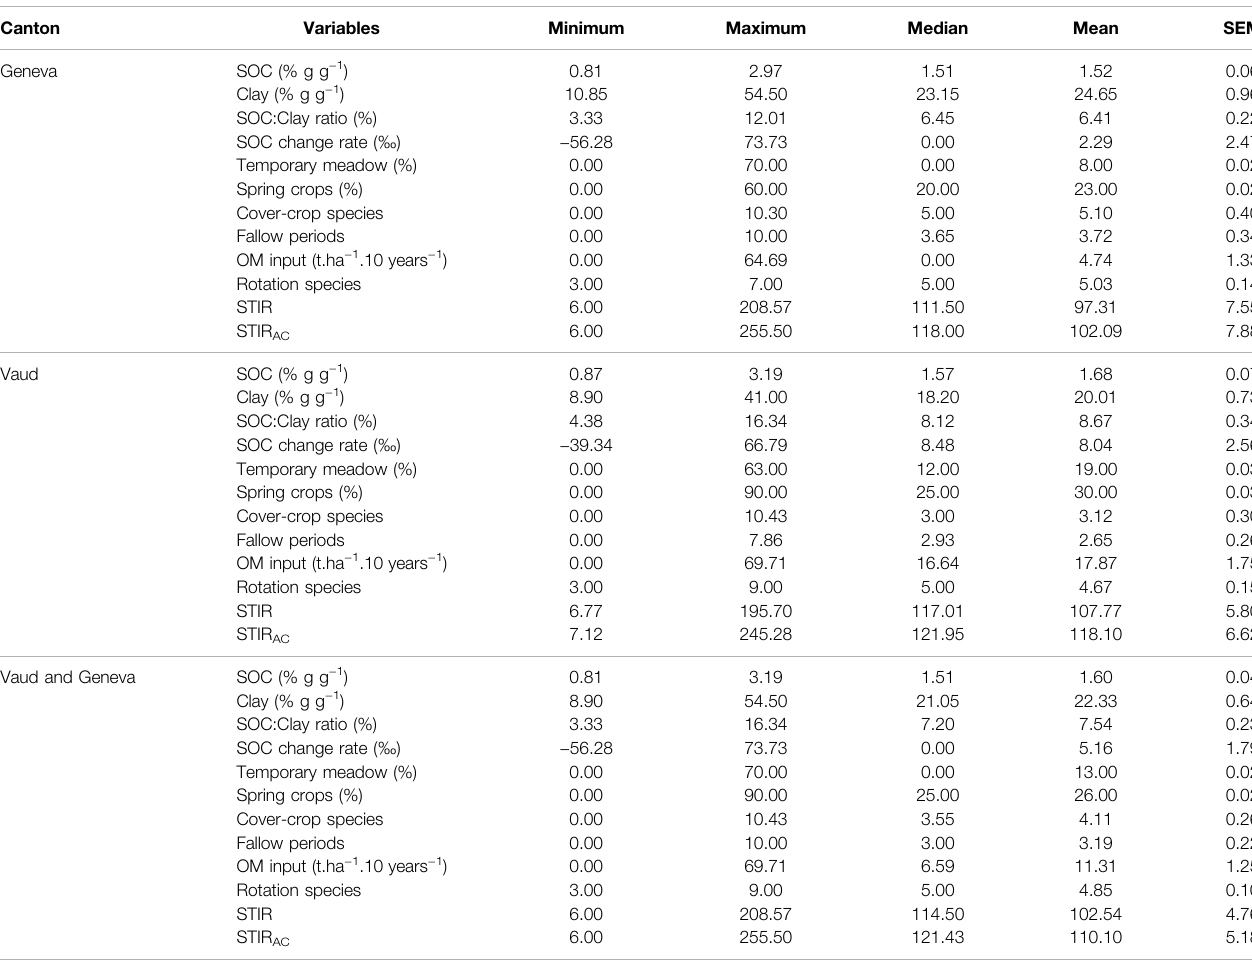
TABLE 3 | Summary of the main soil properties and cropping practices. Soil organic carbon content (SOC) (%) and clay content (%) at the beginning of the 10-year period and their ratio(SOC:Clay ratio) (%). Rate ofSOC annual change ( ‰ ).Share oftemporarymeadows in 10 years (%). Share ofspringcrops in10 years (%). Mean number of species in the cover-crops. Number of fallow periods in 10 years. Cumulated organic matter amendments in humi fi ed organic matter in tons per 10 years. Number of species in the rotation. STIR: Mean Soil Tillage Intensity Rating per year over the 10-year period. STIR AC : Mean Soil Tillage Intensity Rating per year over the 10-year period.